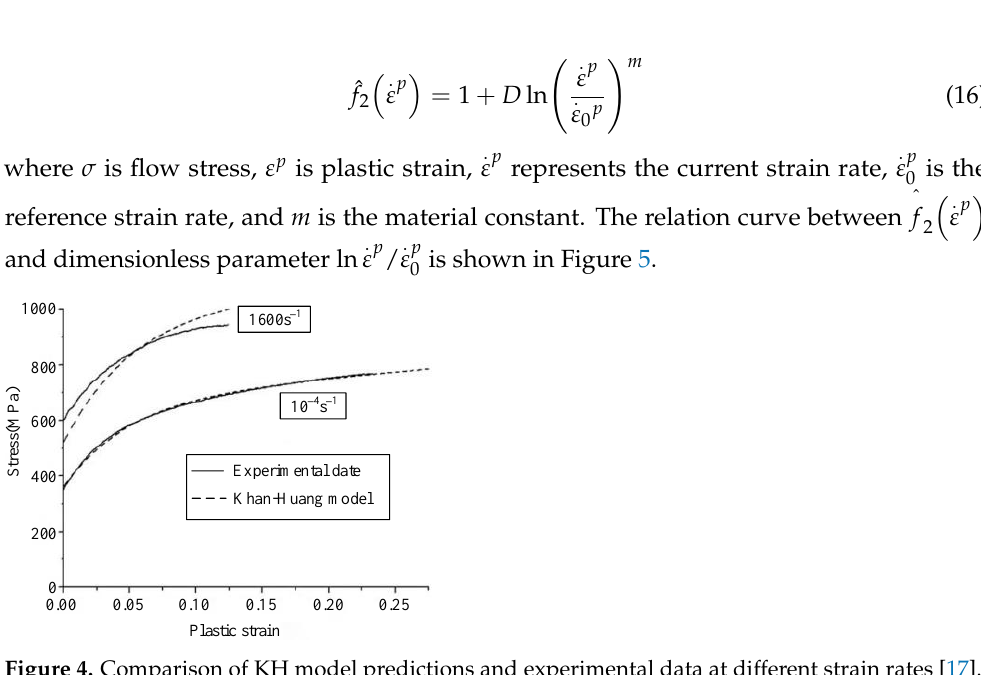
where σ is flow stress, 𝜀 𝑝 is plastic strain, 𝜀̇ 𝑝 represents the current strain rate, 𝜀̇ 0𝑝 is the reference strain rate, and m is the material constant. The relation curve between 𝑓̑ (𝜀̇ 𝑝 ) and dimensionless parameter ln𝜀̇ 𝑝 𝜀̇ 0𝑝 ⁄ is shown in Figure 5. Figure 4. Comparison of KH model predictions and experimental data at different strain rates [17].